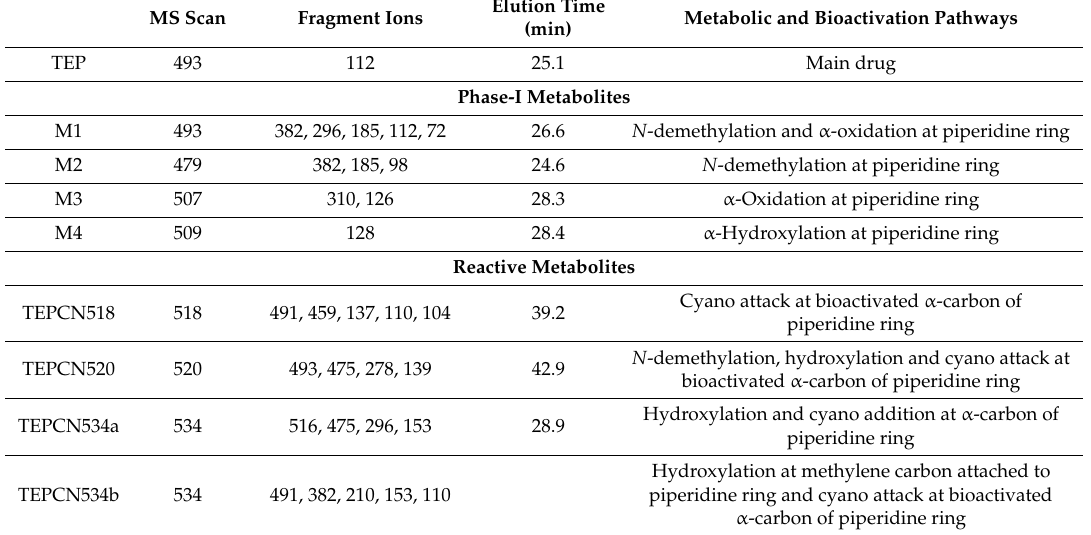
Table 2. In vitro phase-I metabolites and cyano adducts of